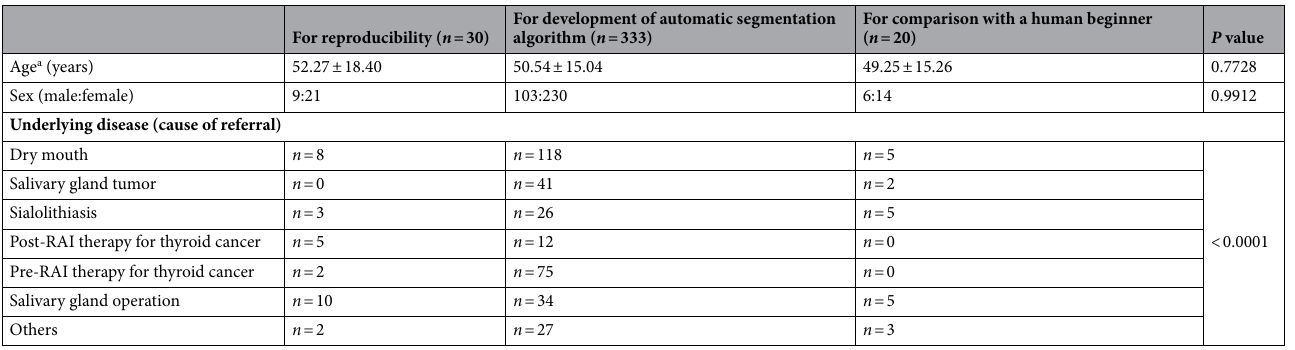
Table 4. Patient characteristics. a Age is mean ± standard